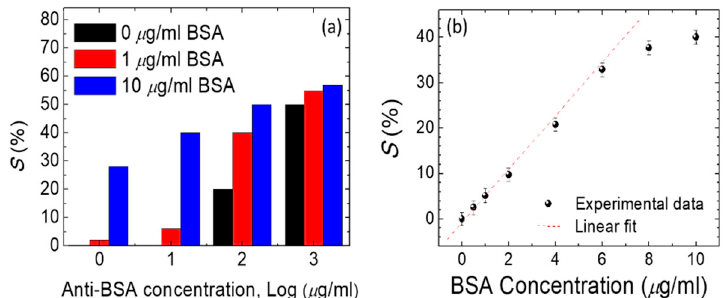
Figure 9. ( a ) Intensities of immunoassay DDLCs immobilized with concentrations of BSA of 0–10 µg/mL along with concentrations of anti-BSA antibody of 0, 10, 100, and 1000 µg/mL, ( b ) Relationship in the parameter of standard S % (the wavelength transmittance-related loss) and BSA concentrations at an anti-BSA concentration of 1 µg/mL.